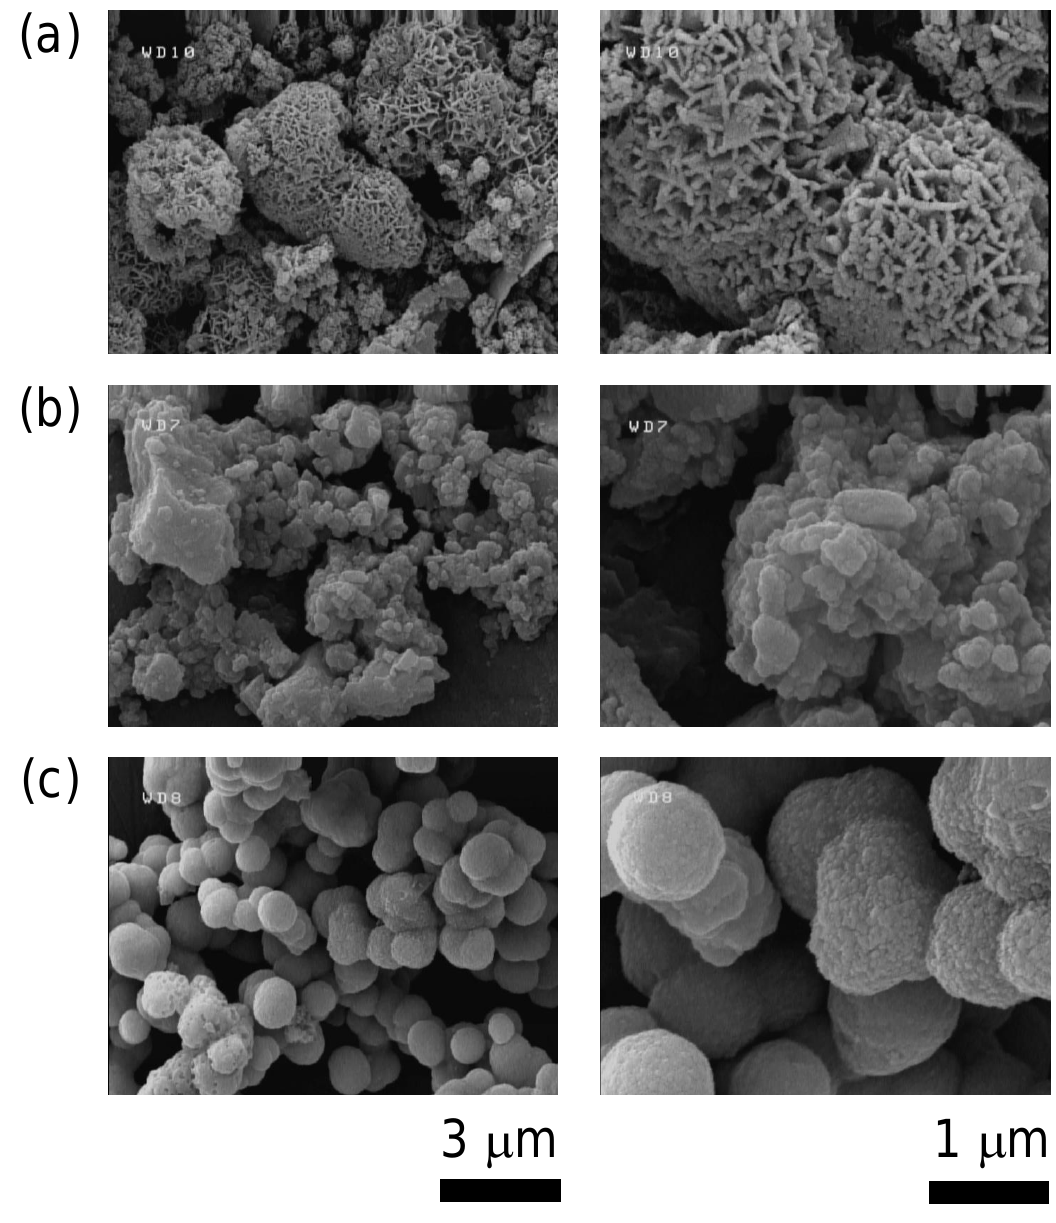
Figure 1. SEM micrographs of ( a ) CoP, ( b ) MoP, and ( c ) NiP.